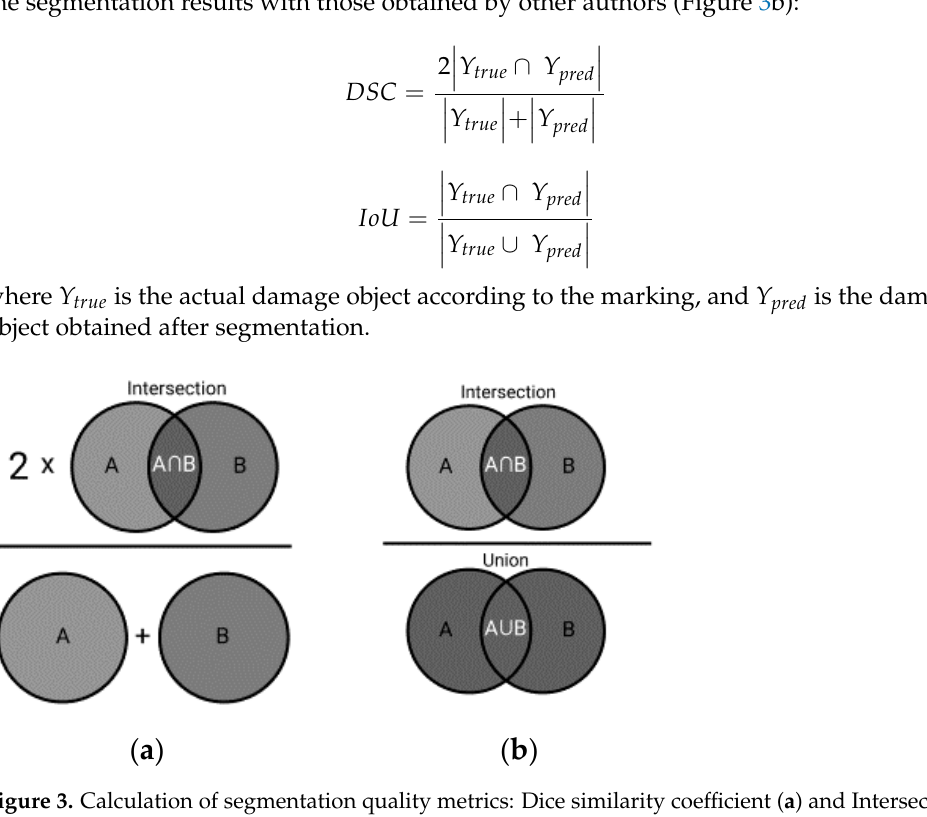
Figure 2. Examples of surface scratches and abrasions ( a ) and undamaged surfaces ( b ).